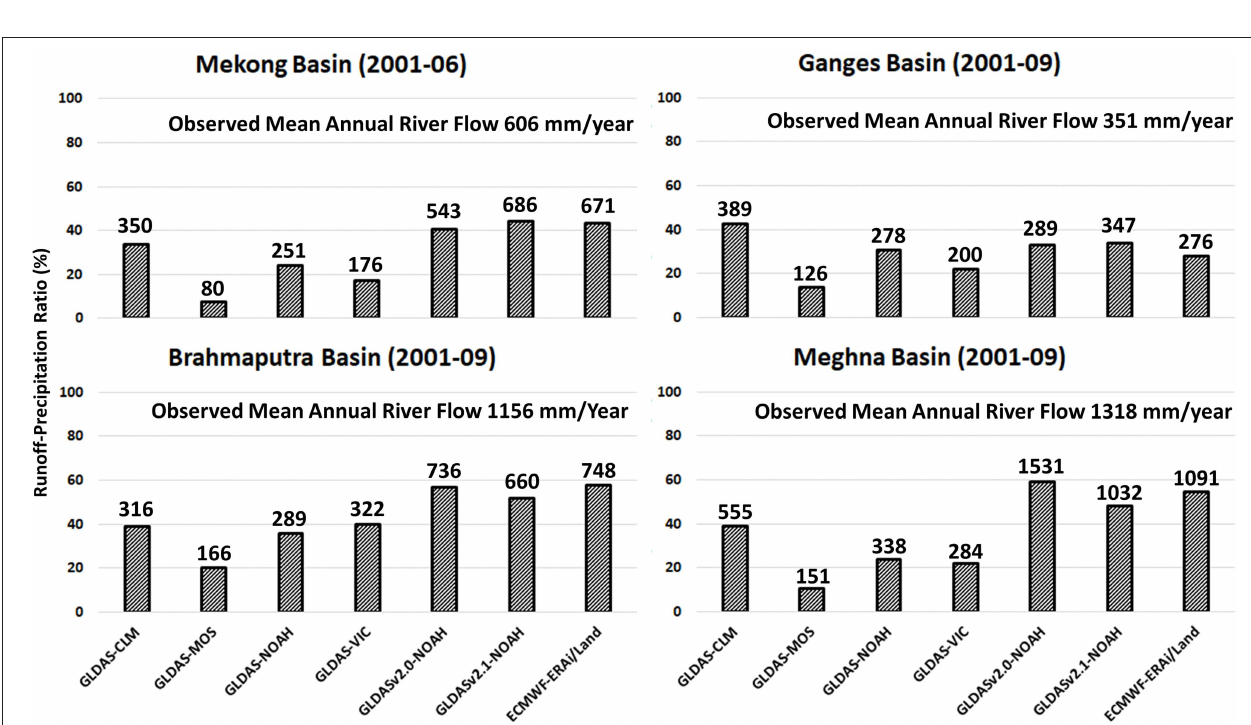
Frontiers in Environmental Science | www.frontiersin.org